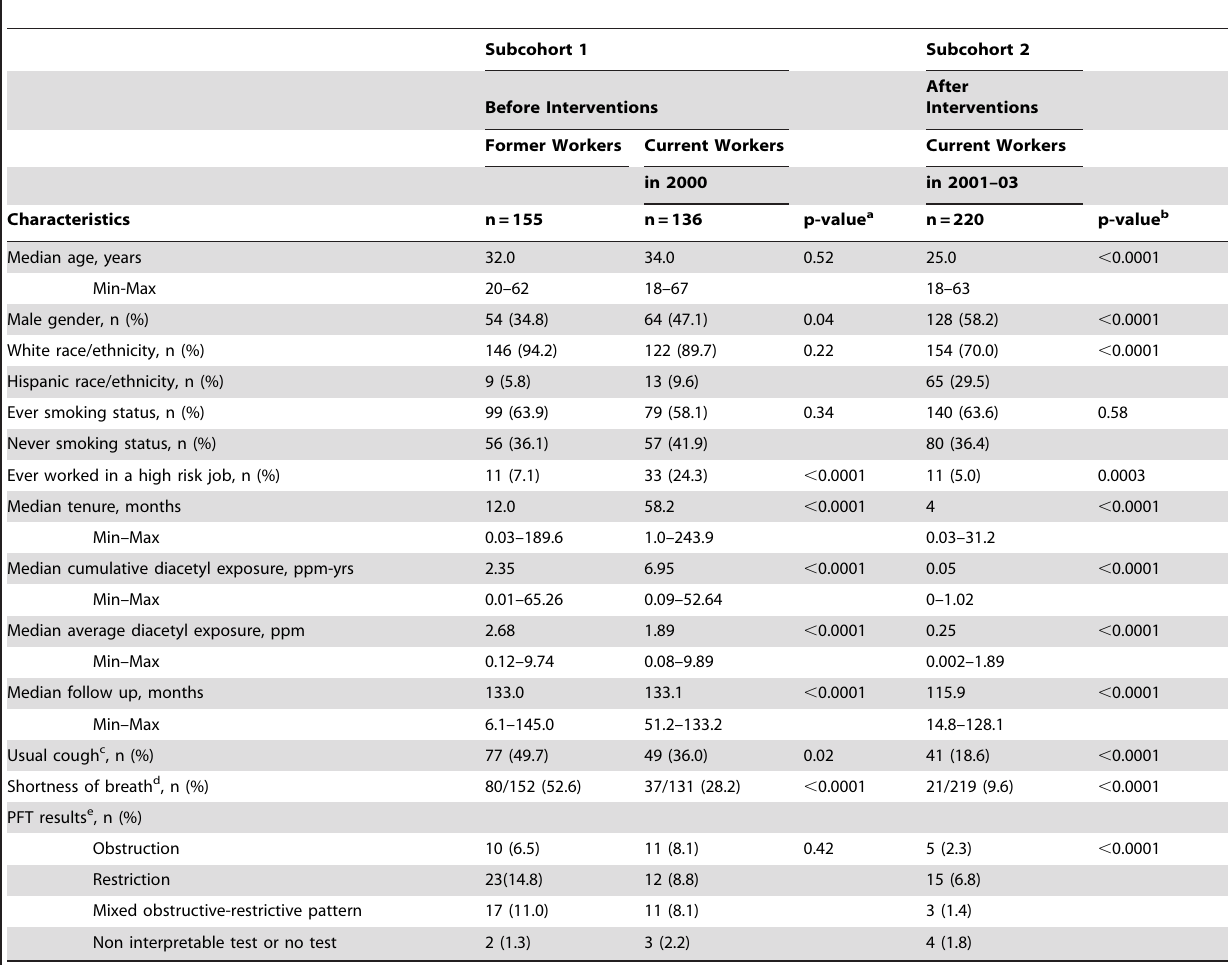
Table 1. Characteristics of former and two current worker groups constituting Subcohort 1 before interventions and Subcohort 2 after interventions began to lower